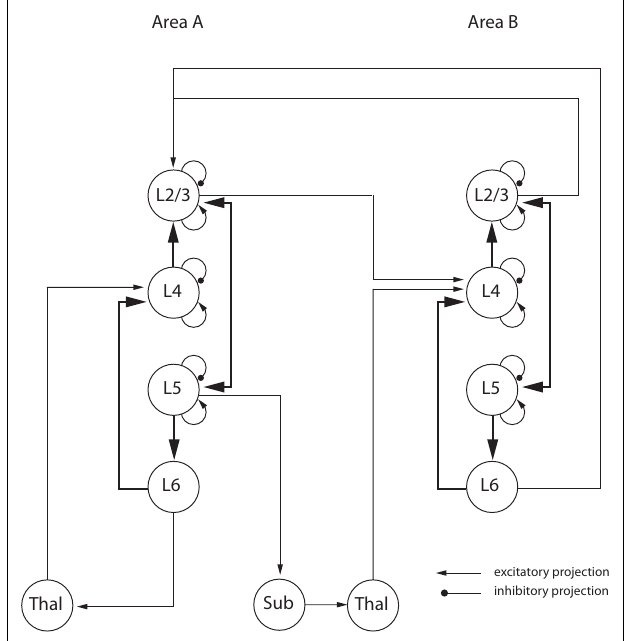
FIGURE 5 | Representation of the major connections in the canonical microcircuit (adapted from Douglas et al., 1989; Douglas and Martin, 1991, 2004) . Excitatory connections are represented by arrows and inhibitory ones as lines with round ends. Neurons from different cortical layers or brain structures are represented as circles. ‘L x ’ designates the cortical layer where the cell body is located, ‘Thal’ designates the thalamus and ‘Sub’ designates other subcortical